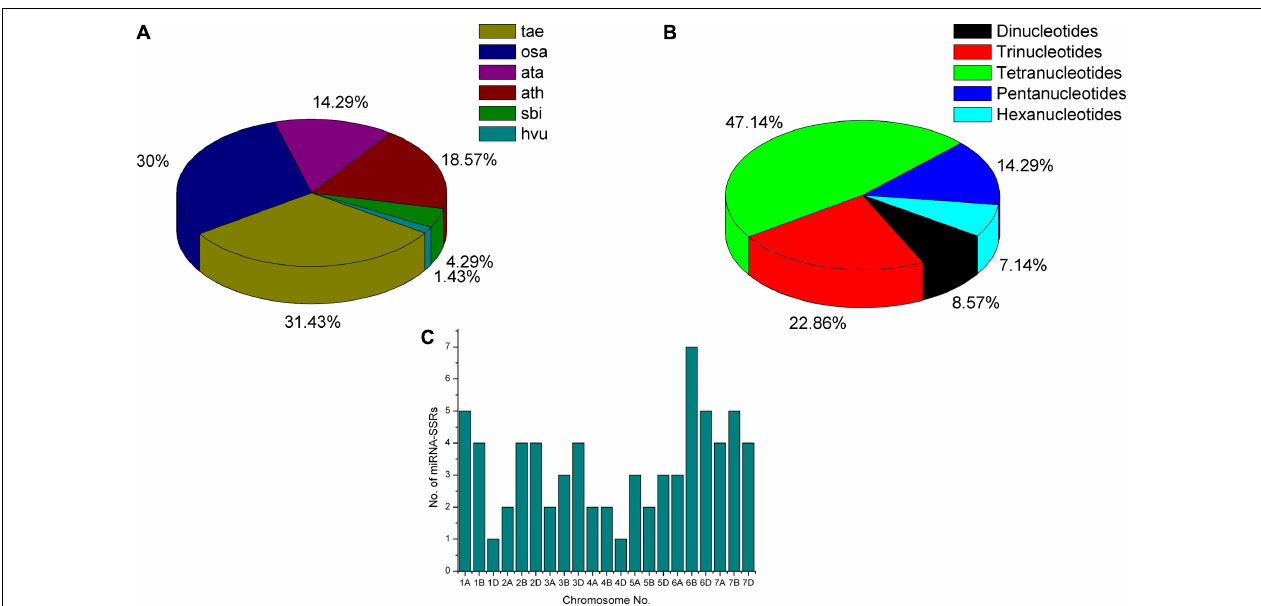
FIGURE 2 | Frequency and distribution of heat-responsive miRNA genes with SSR motifs. (A) Frequency of heat-responsive miRNAs submitted in miRBase reported in various crops. (B) Frequency of wheat miRNA-SSR repeats present in miRNA genes. (C) Distribution of heat-responsive miRNA-SSRs on